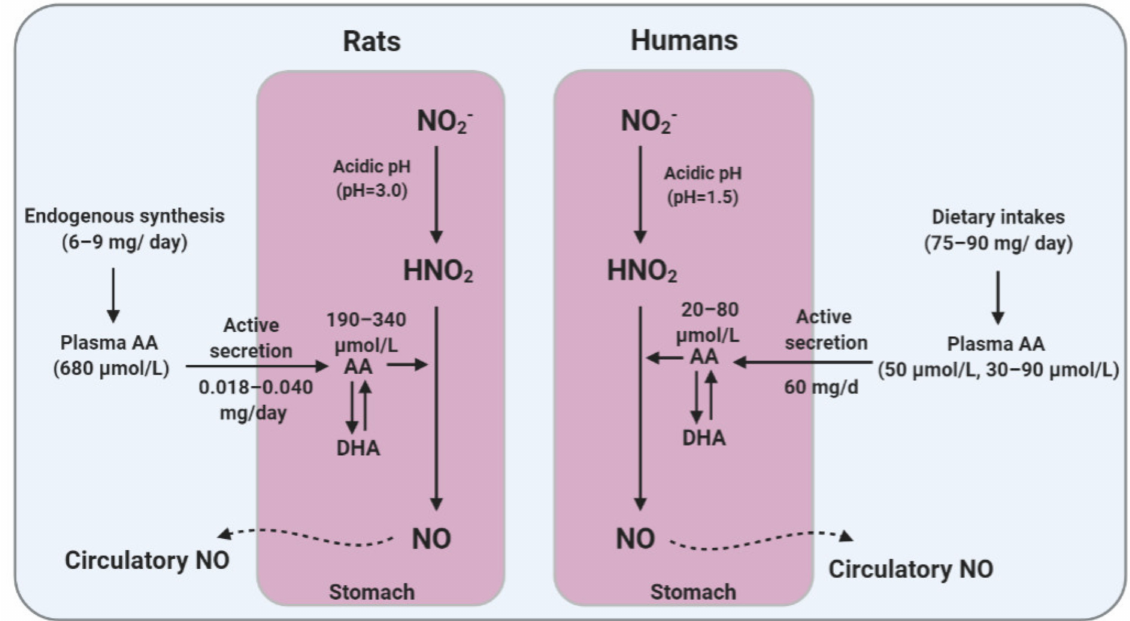
Figure 2. Differences between humans and rats in ascorbic acid (AA) metabolism and gastric AA secretion that may affect the efficacy of gastric conversion of nitrite (NO 2 − ) to nitric oxide (NO). DHA, dehydroascorbic